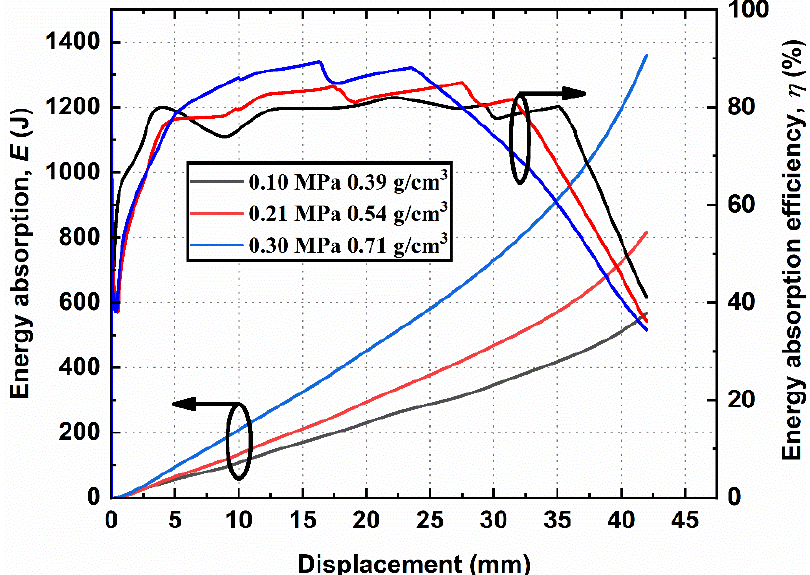
η -displacement curves of three kinds of foam-filled Figure 9. Graphs of the E -displacement and  -displacement curves of three kinds of foam-filled tubes. Figure 9. Graphs of the E -displacement and